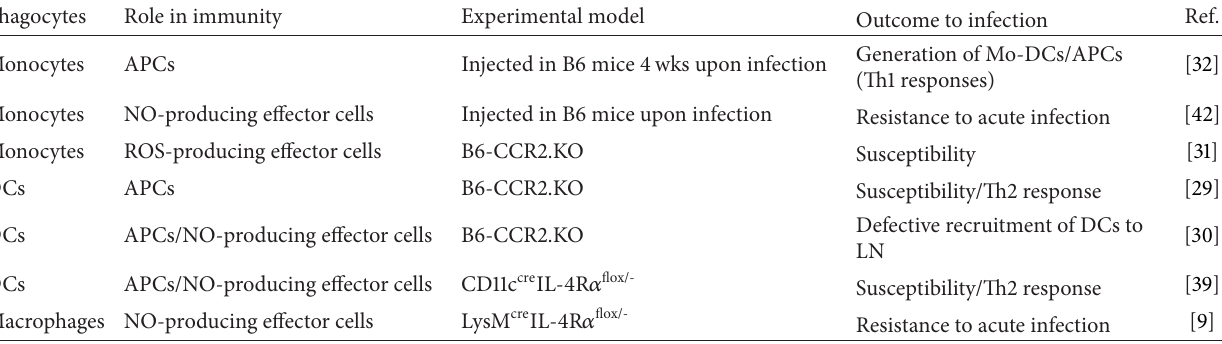
Table 1: The role of phagocytes and IL-4 in immunity to L. major infection.